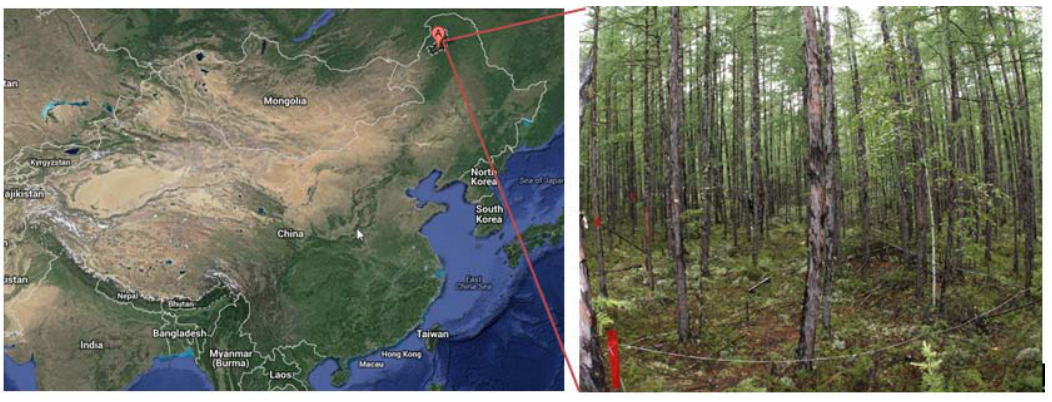
Figure 5. Location of the experiment area and the photo taken in the forest